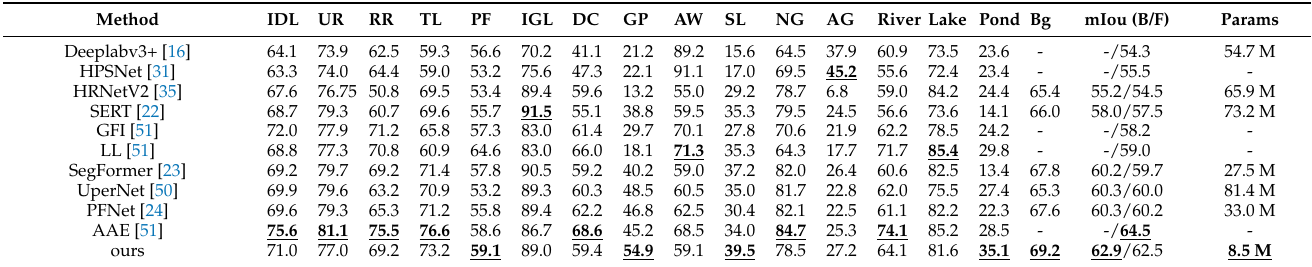
Table 10. Comparison with the state-of-the-art networks on the GID-15 dataset. The abbreviations for classes are IDL-industrial land, UR-urban residential, RR-rural residential, TL-traffic land, PF-paddy field, IGL-irrigated land, DC-dry cropland, GP-garden plot, AW-arbor woodland, SL-shrub land, NG-natural grassland, AG-artificial grassland, and